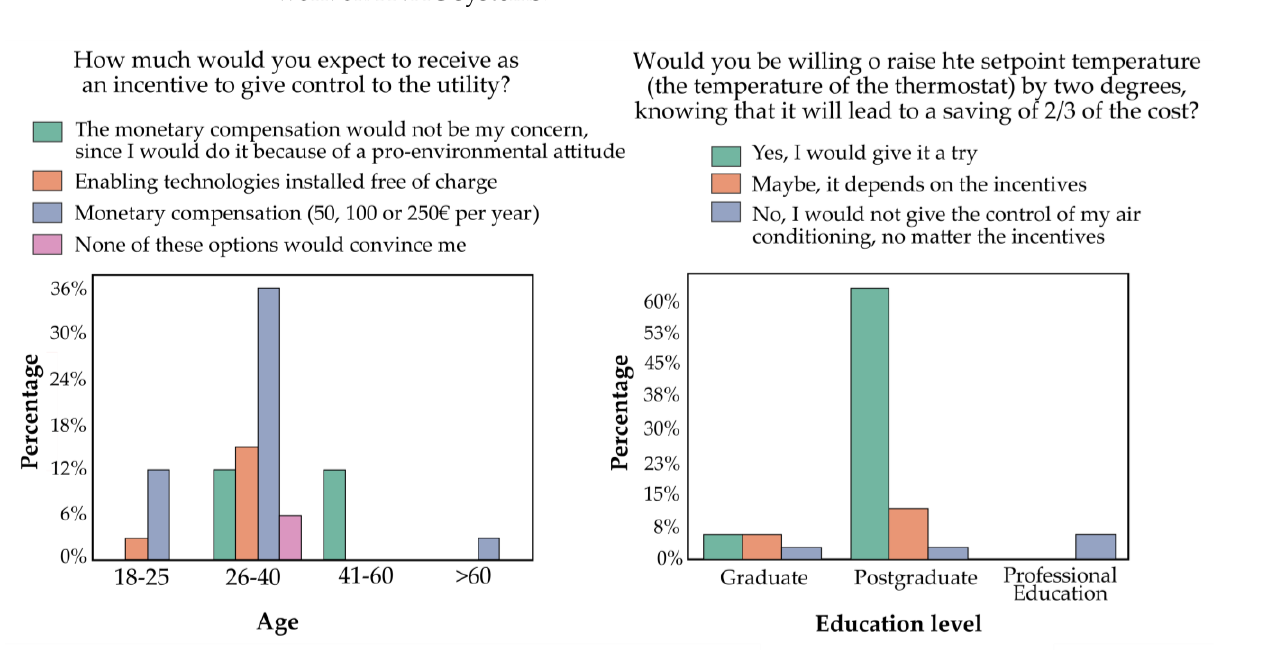
Figure 4. Countplots of the significant differences in the demographics on the HVAC items in the questionnaire. The y -axis expresses the percentage of respondents, while on the x -axis, the categories of the independent variables are shown.